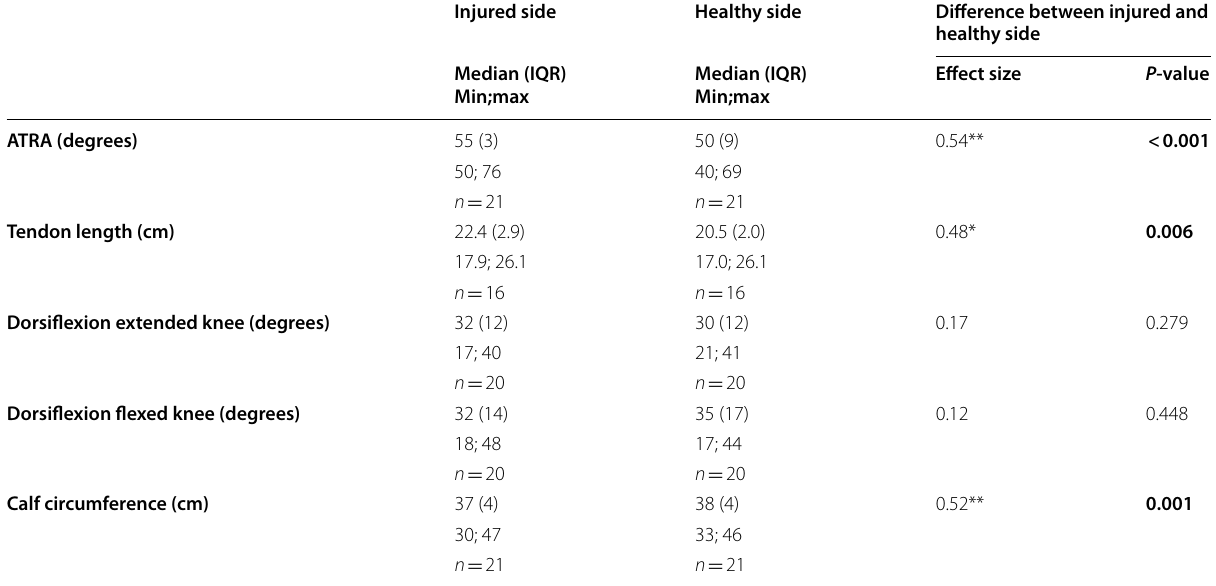
Table 4 Clinical measurements in patients with